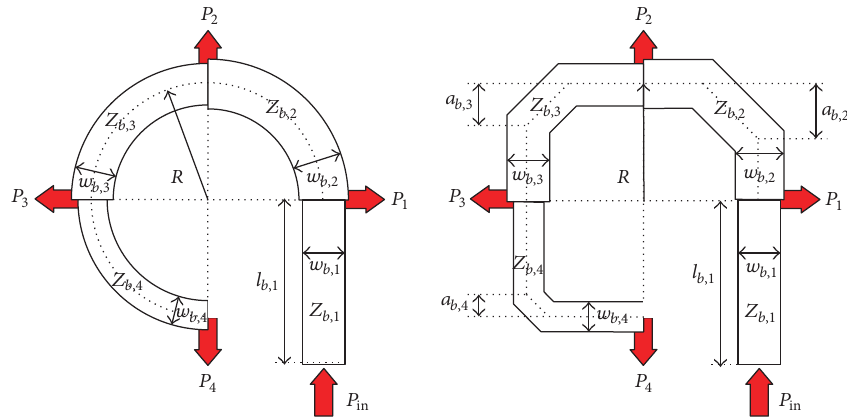
Figure 2: Open ring and open octagon implementations of the series power